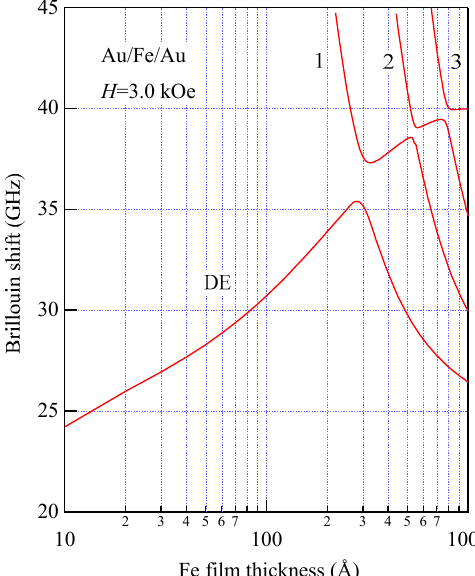
Figure 11. Calculated SW frequencies ( − ) propagating along the [110] direction on the epitaxial (001) Fe film as a function of the film thickness. The magnetic field was applied along the [1–10] direction, and the cubic MAE and the effective demagnetization factor D ⊥ were included in this calculation. The broken lines are just for eye.